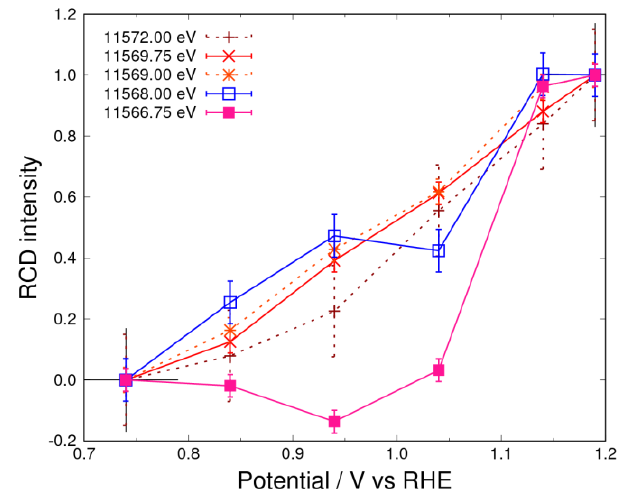
Figure 8. RCD curves for the controlled potential above 0.74 V in 1 M of KOH saturated with O 2 . The standard potentials are 0.74 V and 1.19 V. The filled and open square curves represent the negative and positive peak of 11,566.75 eV and 11,568.00 eV, respectively. The dashed lines complement the explanation for RCD.